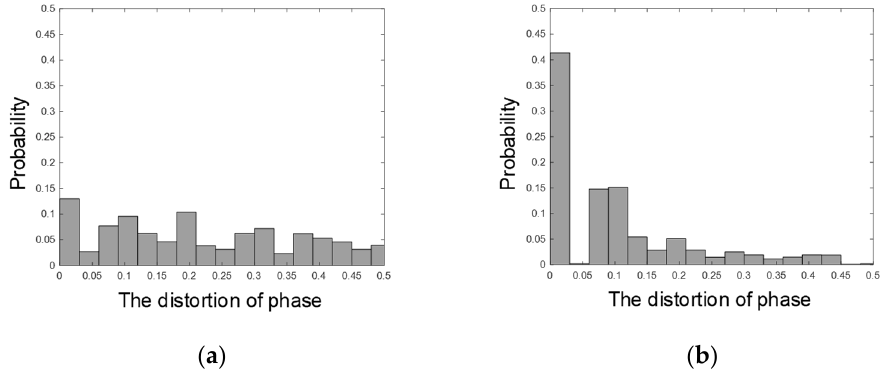
Figure 5. The probability density functions of phase distortions for ( a ) DAE_AP and ( b ) DAE_IP.